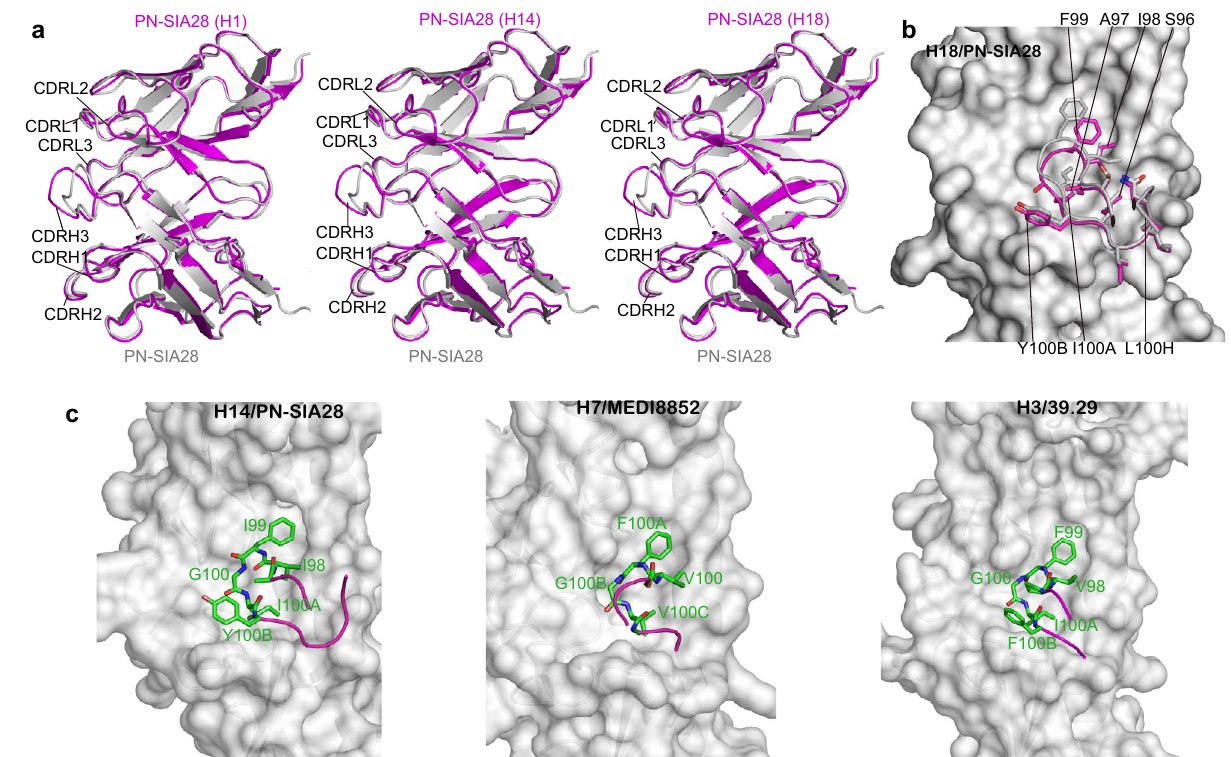
Fig. 6 | PN-SIA28 binds to a conserved stem region of HA through CDRH3 conformational rearrangements upon complex formation. a Overlay of PN- SIA28 bound to H1, H14, or H18 (magenta) and the PN-SIA28 Fab alone (grey). The CDRsofPN-SIA28arelabeled. b ConformationalrearrangementsinPN-SIA28upon complex formation. Conformational change of the CDRH3 loops upon HA engagement. The CDRH3 of the apo and bound structures is colored gray and magenta,respectively. The beginning and end of the moving regions areindicated